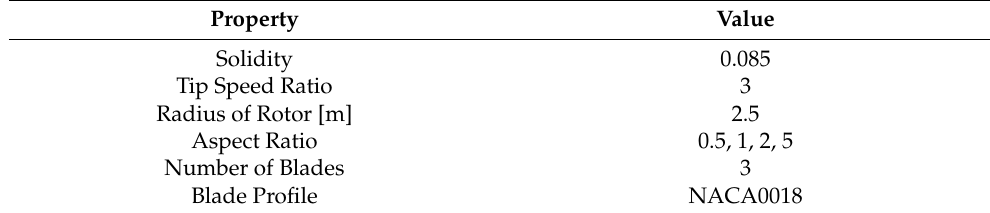
Table 1. Principal particulars of Model 1 (two straight-blade